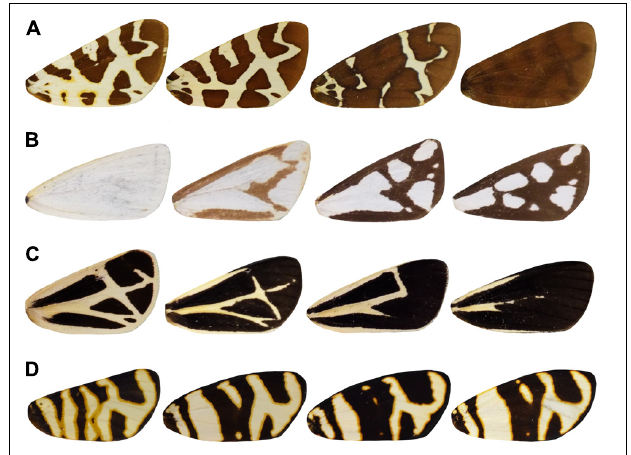
FIGURE 1 | Intraspecific variation in arctiid dorsal forewing patterning. Many arctiid species show extremely high levels of intraspecific phenotypic variation, with various pattern elements being significantly expanded or reduced in size, and even merged with adjoining elements. Examination of large numbers of specimens found in museum collections reveals that this variation is often continuous. Row (A) : Arctia caja ; row (B) : Haploa confusa ; row (C) : Apantesis nais ; row (D) : Eucharia festiva .